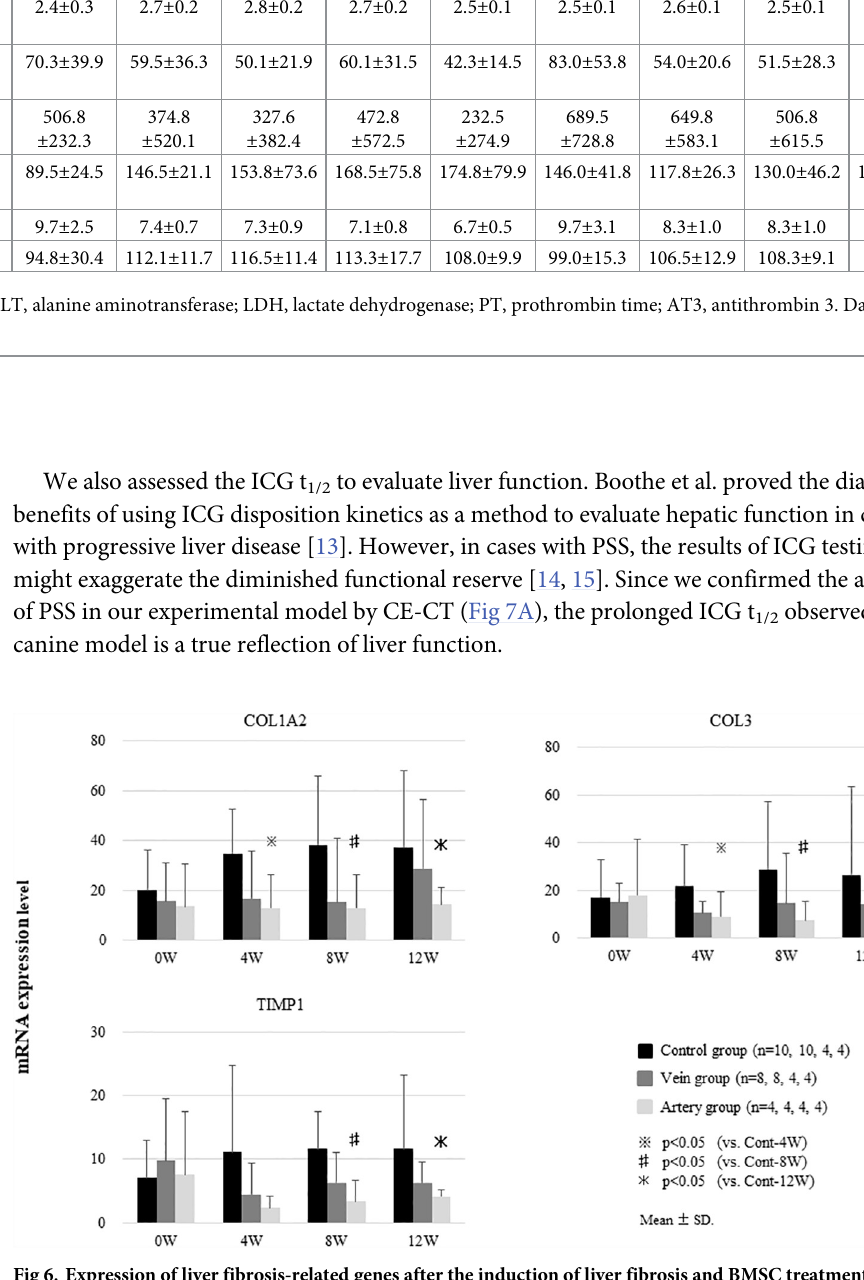
Fig 6. Expression of liver fibrosis-related genes after the induction of liver fibrosis and BMSC treatment. After the induction of liver fibrosis, canines were treated with BMSCs via the peripheral vein (Vein group) or hepatic artery (Artery group). The expression of COL1A2 , COL3 , and TIMP-1 mRNA tended to decrease in the Vein group compared to that the Control group, although the differences were not significant. In the Artery group, the expression levels of COL1A2 , COL3 , and TIMP-1 were significantly lower than those in the Control group at 4, 8, and 12 weeks. Data show the mean ± standard